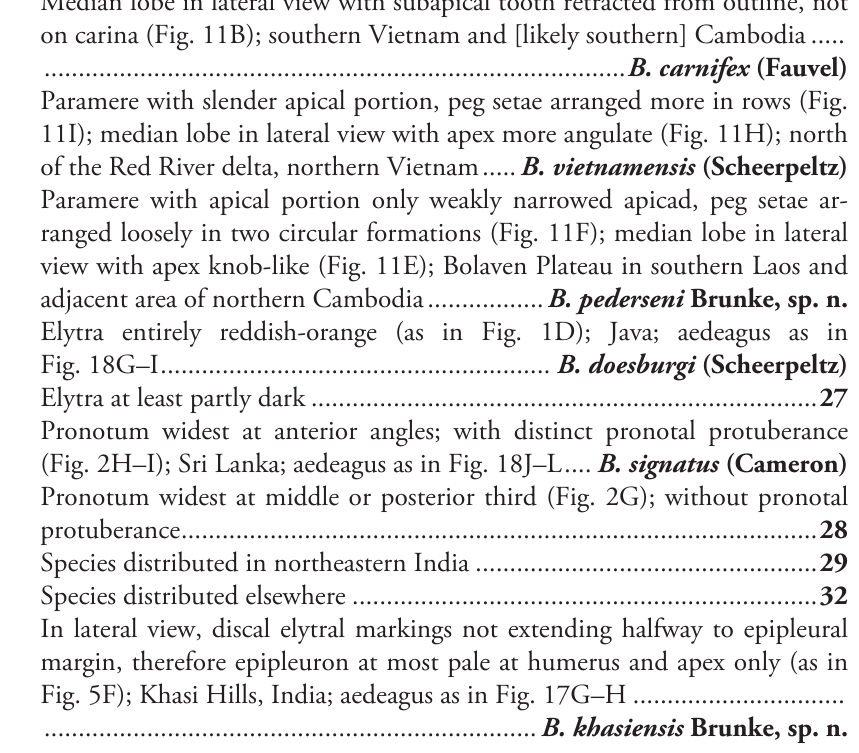
Peg setae arranged in one group removed from margin (Fig. 12A–C); Hain- – Peg setae arranged in lateral and medial groups (Fig. 11C, F, I, L, O); main- 22 Visible abdominal tergites 1–3 with relatively small dark median spots, oc- cupying less than 1/3 of the tergal width (Fig. 5B); median lobe in parameral view (paramere removed) with basal pair of teeth placed medially (Fig. 11J, M); southern Yunnan, China, northern Laos and central Thailand ........... 23 – Visible abdominal tergites 1–3 with relatively wide dark median spots, occu- pying more than 1/3 of the tergal width (Fig. 5C); median lobe in parameral view (paramere removed) with basal pair of teeth placed laterally (Fig. 11A, D, G); southern Laos, Cambodia, southern Vietnam ................................ 24 23 Antennomeres 8–10 quadrate; paramere with apex only slightly narrowed (Fig. 11O); apex of median lobe in parameral view acuminate (Fig. 11M); – Antennomeres 8–10 transverse; paramere strongly narrowed to apex (Fig. 11L); apex of median lobe in parameral view evenly converging to apex (Fig. 11J); 24 Median lobe in lateral view with subapical tooth on distinct carina (Fig. 11E, H); northern Vietnam to southern Laos and northern Cambodia ............. 25 – Median lobe in lateral view with subapical tooth retracted from outline, not on carina (Fig. 11B); southern Vietnam and [likely southern] Cambodia ..... 25 Paramere with slender apical portion, peg setae arranged more in rows (Fig. 11I); median lobe in lateral view with apex more angulate (Fig. 11H); north of the Red River delta, northern Vietnam ..... B. vietnamensis (Scheerpeltz) – Paramere with apical portion only weakly narrowed apicad, peg setae ar- ranged loosely in two circular formations (Fig. 11F); median lobe in lateral view with apex knob-like (Fig. 11E); Bolaven Plateau in southern Laos and adjacent area of northern Cambodia ................. B. pederseni Brunke, sp. n. 26 Elytra entirely reddish-orange (as in Fig. 1D); Java; aedeagus as in – 27 Pronotum widest at anterior angles; with distinct pronotal protuberance (Fig. 2H–I); Sri Lanka; aedeagus as in Fig. 18J–L .... B. signatus (Cameron) – Pronotum widest at middle or posterior third (Fig. 2G); without pronotal 28 – 29 In lateral view, discal elytral markings not extending halfway to epipleural margin, therefore epipleuron at most pale at humerus and apex only (as in Fig. 5F); Khasi Hills, India; aedeagus as in Fig. 17G–H